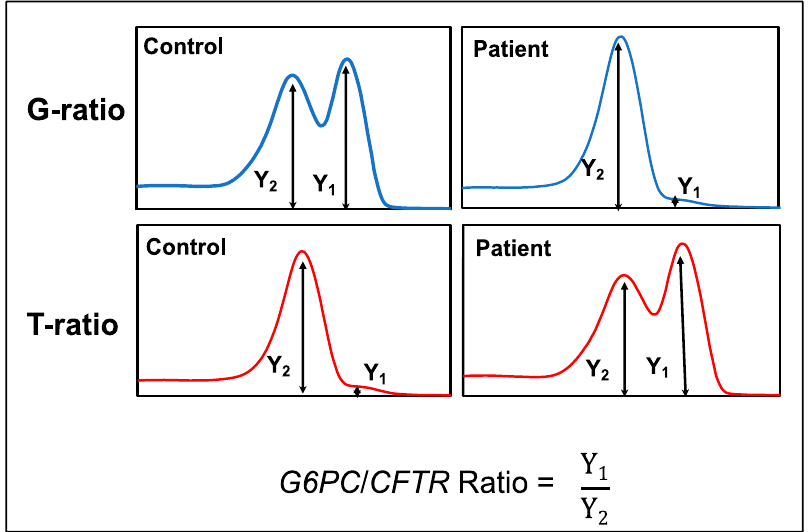
Figure 4. Scheme and formula to calculate the G6PC/CFTR ratio (GCR) values.